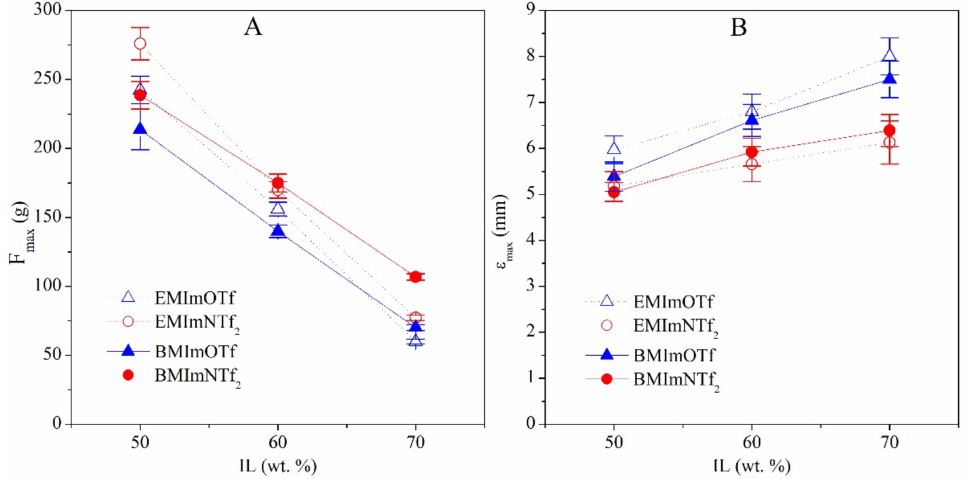
Figure 3. Puncture strength of ionogels: dependence of ( A ) maximum load needed to puncture the sample, F max , and ( B ) maximum elongation, ε max , on the IL content in the ionogels.